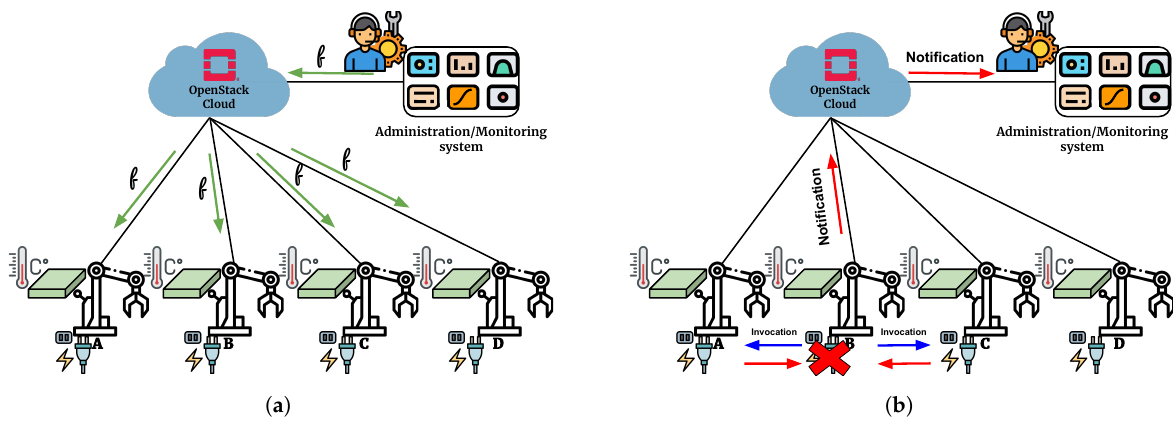
Figure 14. Example of a function-based pipeline on cyber physical system devices through exploitation of a platform offering an edge-based FaaS system: ( a ) The administrator injects the functions generated by pipeline to the devices. ( b ) The workflow is activated when the triggering event